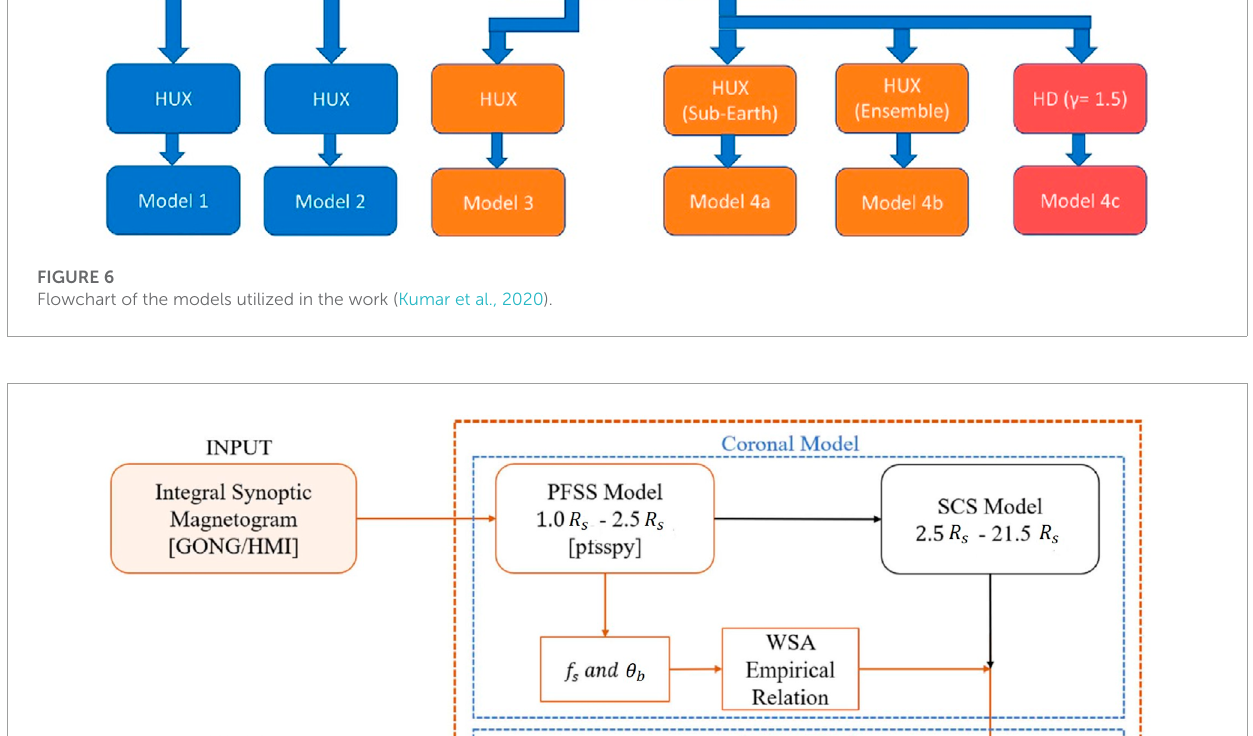
FIGURE 7 Process flow diagram of the proposed solar wind model showing the range of numerical models involved in the inner heliospheric model (Mayank et al.,